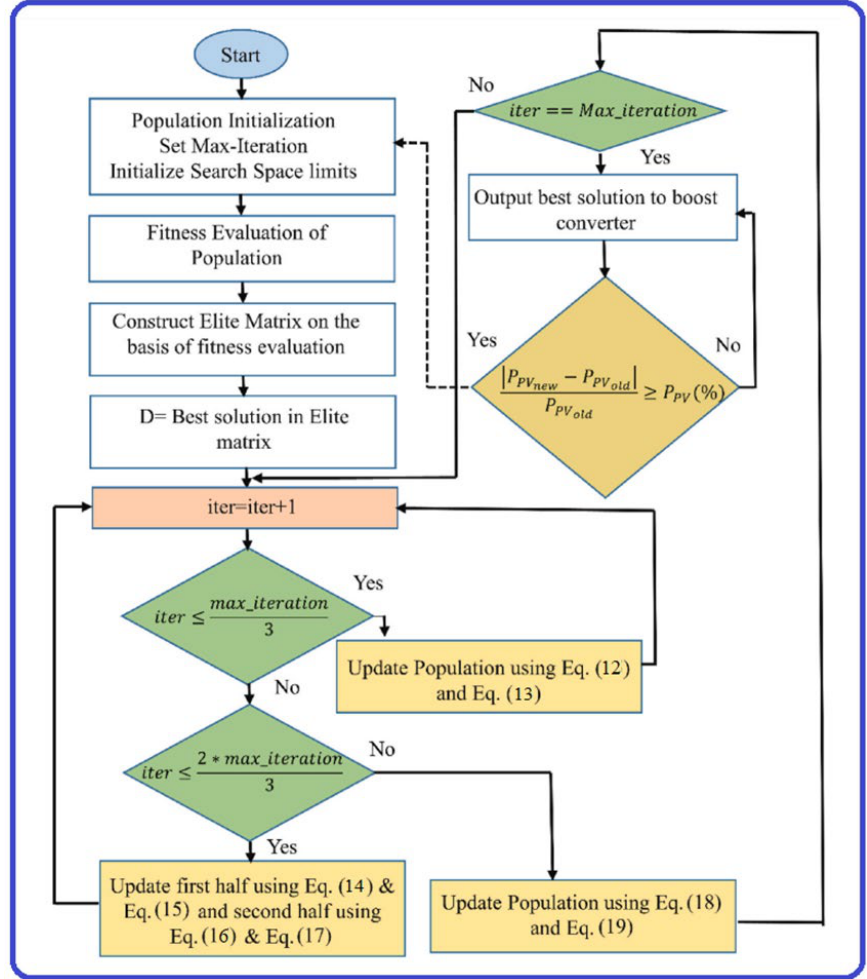
Figure 6. Flowchart for marine predator algorithm-based MPPT. Algorithm1: MPA-based MPPT Pseudo-code